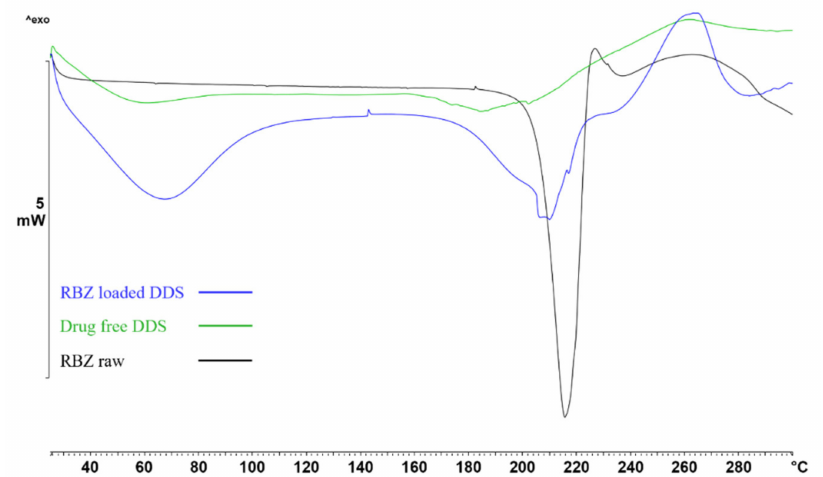
Figure 4. Thermographs of RBZ raw material (black line), drug-free DDS (green line), and RBZ-loaded DDS (blue line).